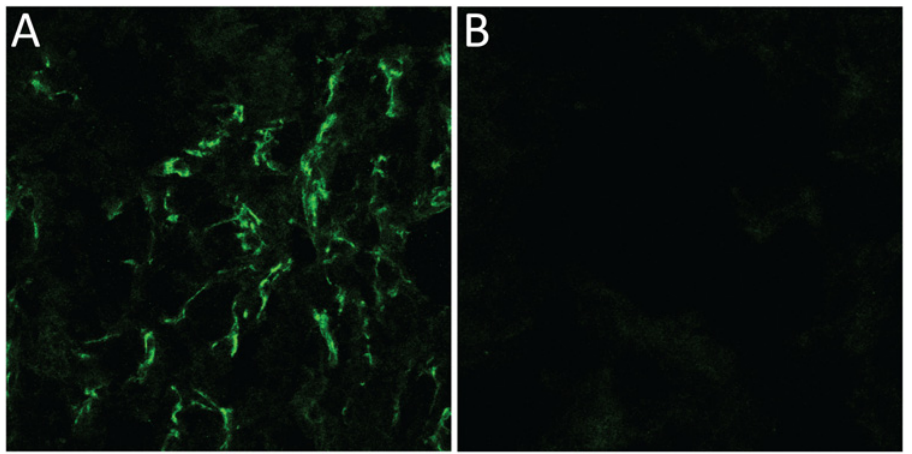
Fig 7. Immunofluorescence picture of murine kidney sections. (A) Anti-Meprin β antibody was used to detect the protease, visualised by fluorescence detection at 488 nm. (B) For the control goat igG was